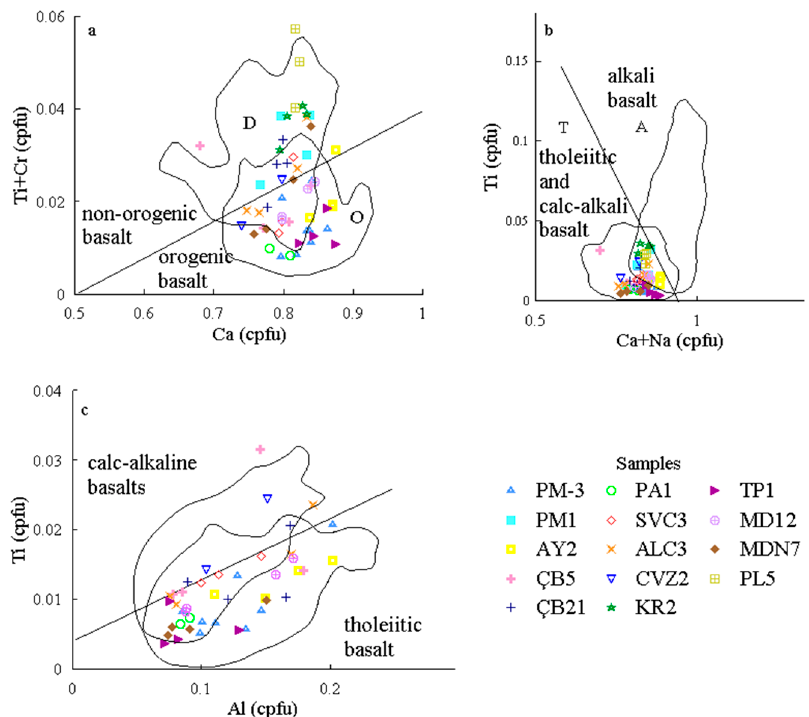
Figure 6. Compositional variation of the clinopyroxene phenocrysts in ( a ) Ca vs. Ti + Cr, ( b ) Ca + Na vs. Ti, and ( c ) Al vs. Ti diagrams after [1]. Identification of magmatic affinities based on the major and minor element composition of clinopyroxene phenocrysts from the Yüksekova Complex.